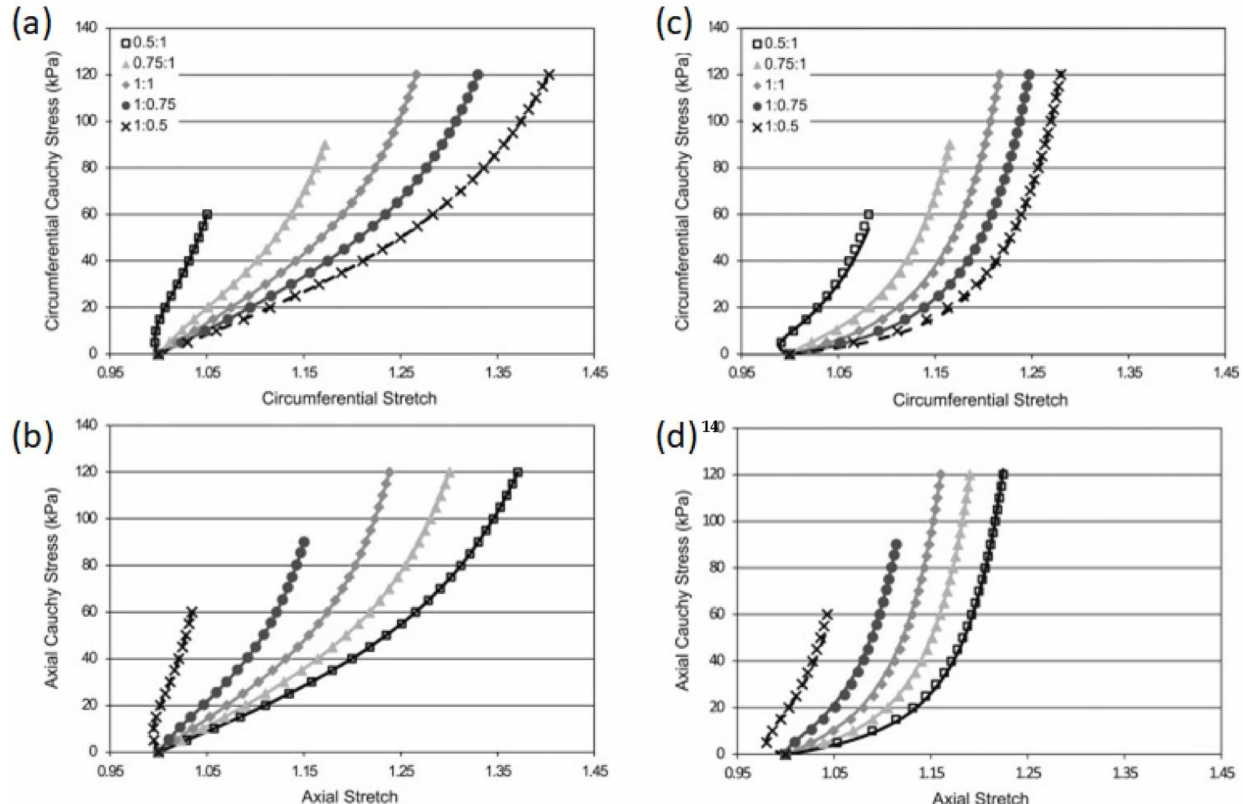
Figure 3. Representative biaxial stress-stretch behavior of healthy cardiovascular tissue. The stress and slope increase with the stretch/strain in any direction. This suggests that the cardiovascular tissue stiffens with stretch/strain which is hypothesized to be a consequence of the progressive engagement of ECM components to resist further deformation. This behavior is modeled by expo- nential functions of the deformation tensor components and/or invariants. Mark symbols in the figures show experimental biaxial test data of the human thoracic aorta for ( a , b ) young patients (20 to 35 years of age), and for ( c , d ) older patients (57 to 71 years of age). Solid lines represent the best-fit approximation with a four-fiber family constitutive equation. Reprinted/adapted with permission from Ref. [37], 2014,